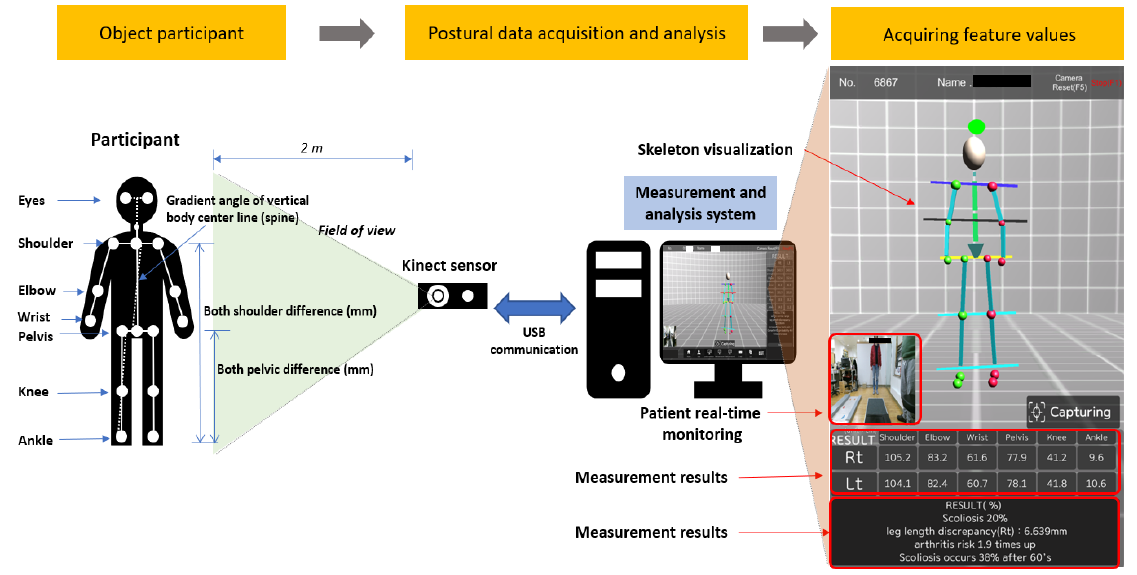
Figure 1. Participant data acquisition using computer vision-based posture analysis system for pre- dictive modeling analysis. predictive modeling